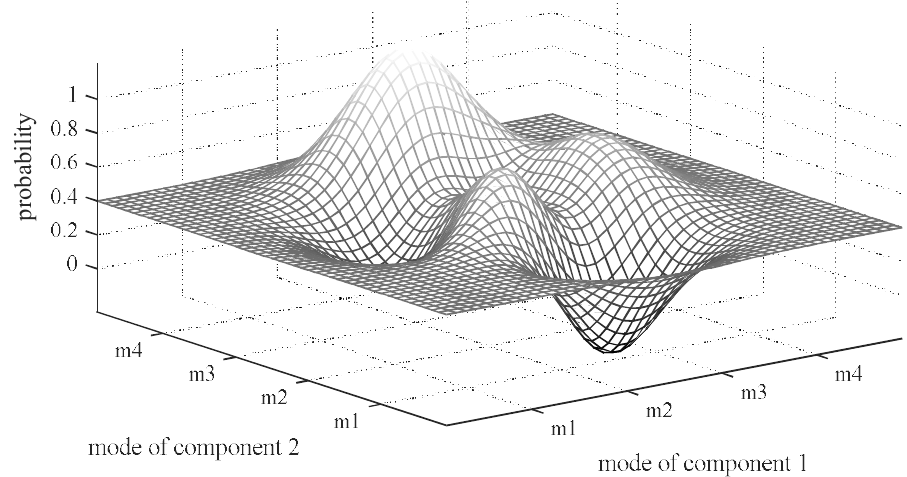
Figure 8. Probabilities of Different Modes Combinations.